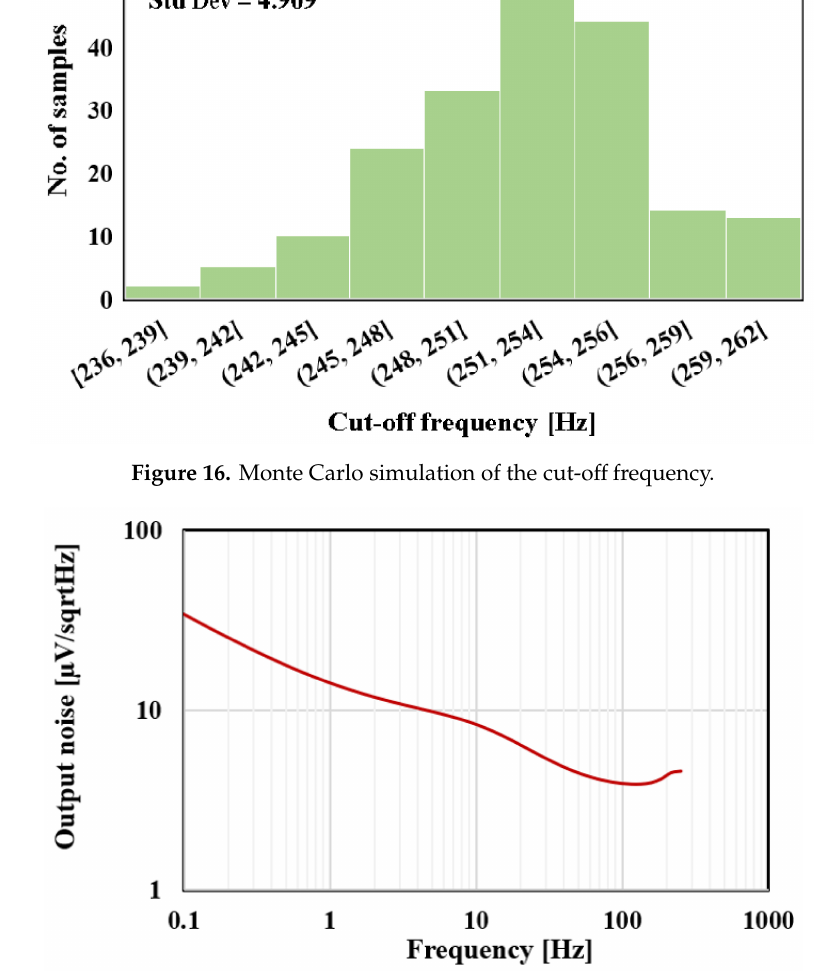
Figure 17. The output referred noise density of the proposed